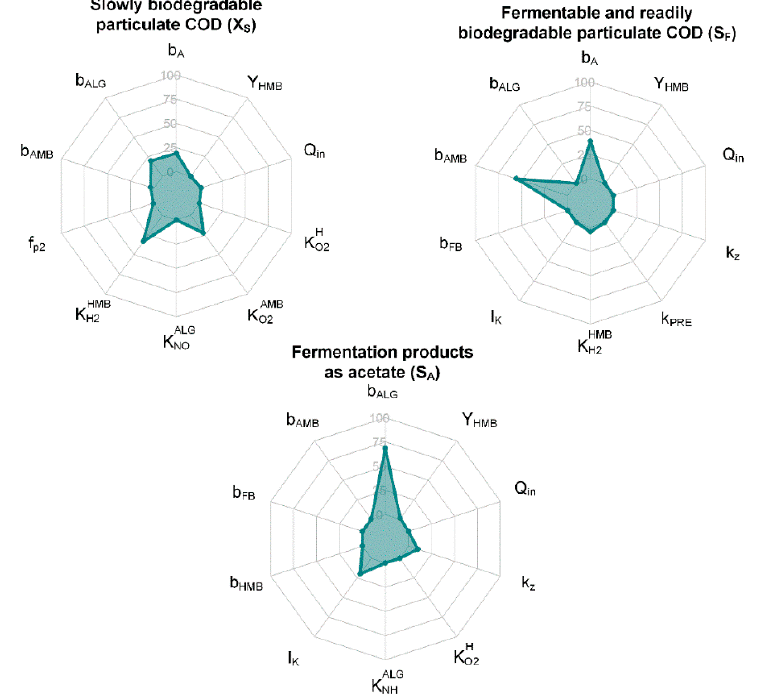
Figure 3. Ten most significant parameters influencing the variability of slowly